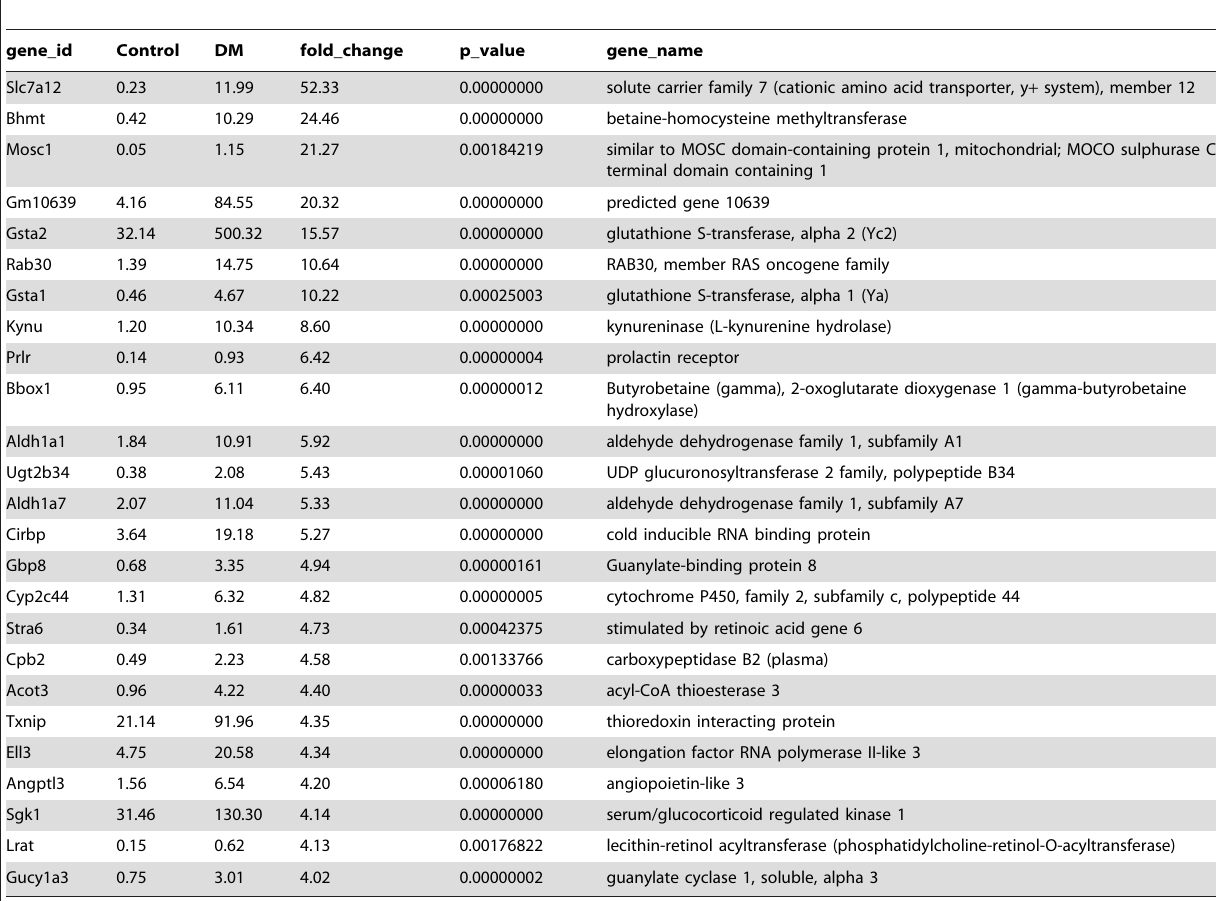
Table 2. All genes exhibiting significantly upregulated renal expression ( . 4-fold increased) with diabetes (OVE26) relative to control